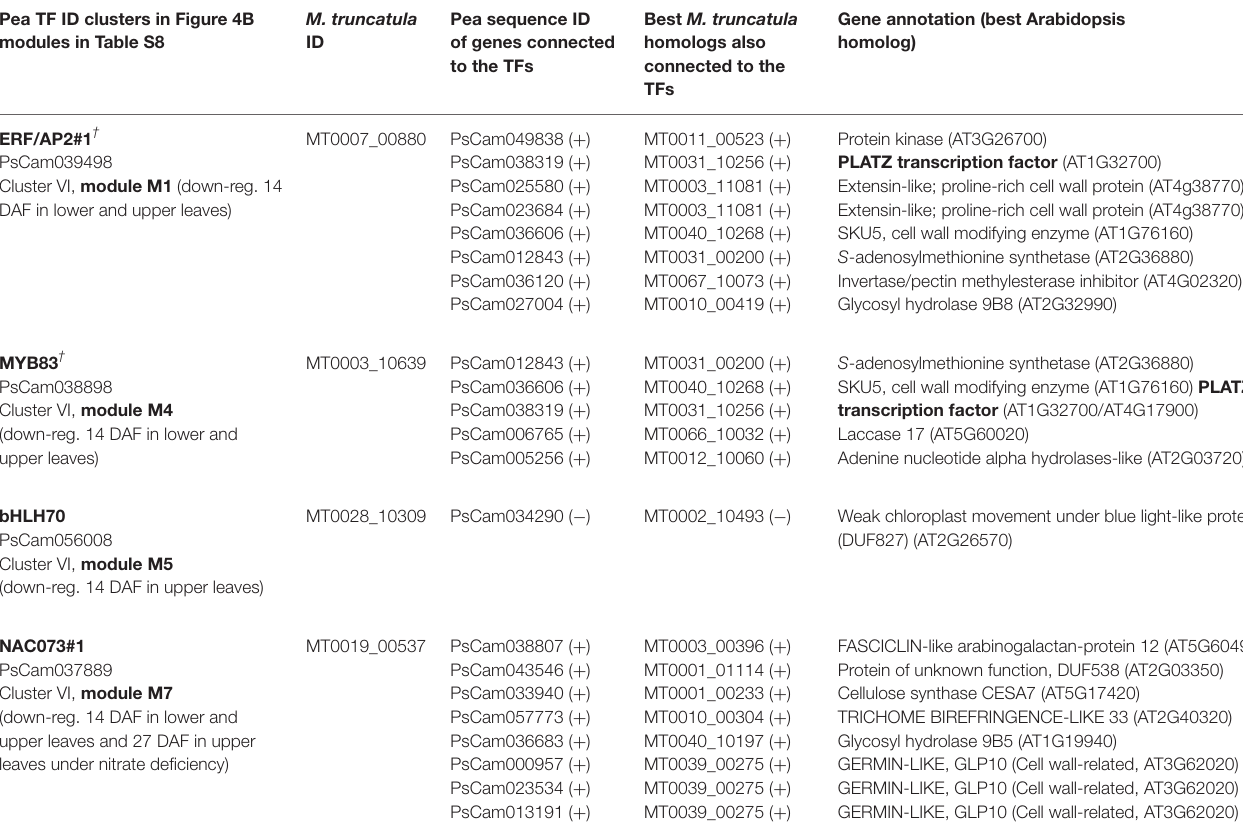
Gene annotation (best Arabidopsis